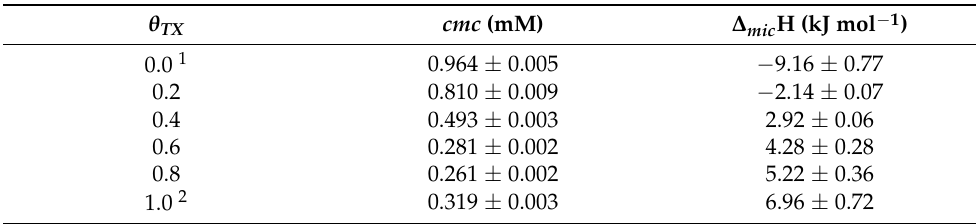
Table 1. ITC determined cmc and Δ mic H values and their standard deviation of the mixed surfactant systems at whole composition ( θ TX ) range at 298 K temperature.